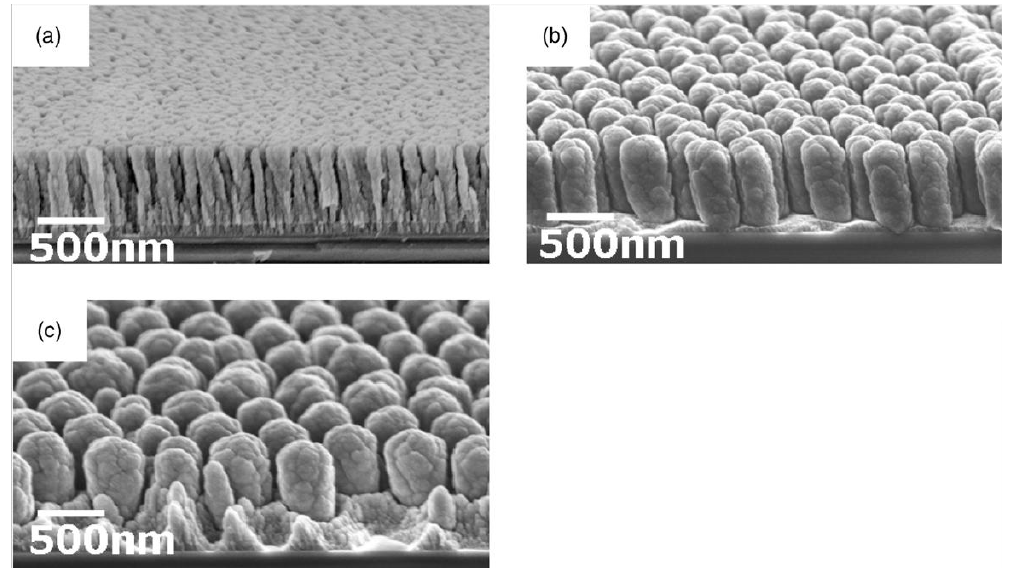
Figure 19 . 15°-tilted cross-sectional SEM micrographs of Si nanocolumns: (a) without template pattern, (b) honeycomb pattern, and (c) hcp pattern. Reprinted with permission from [151]. Copyright 2008, American Institute of